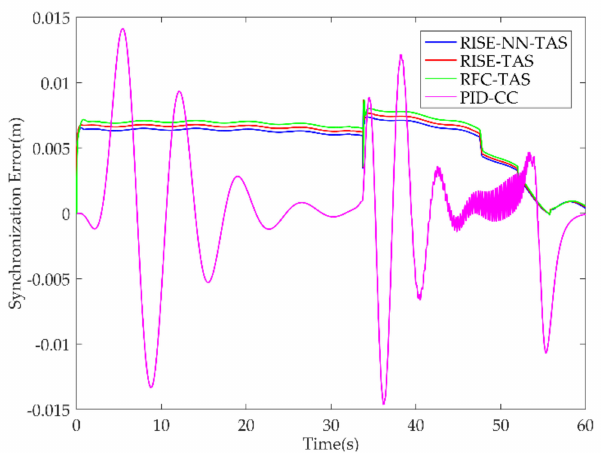
Figure 12. Synchronization errors of the four controllers in case